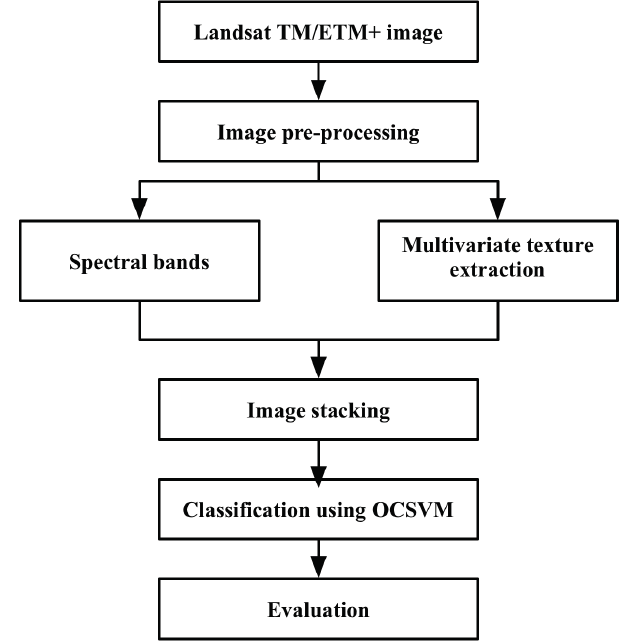
Figure 1. Flowchart of the proposed method. OCSVM, one-class support vector